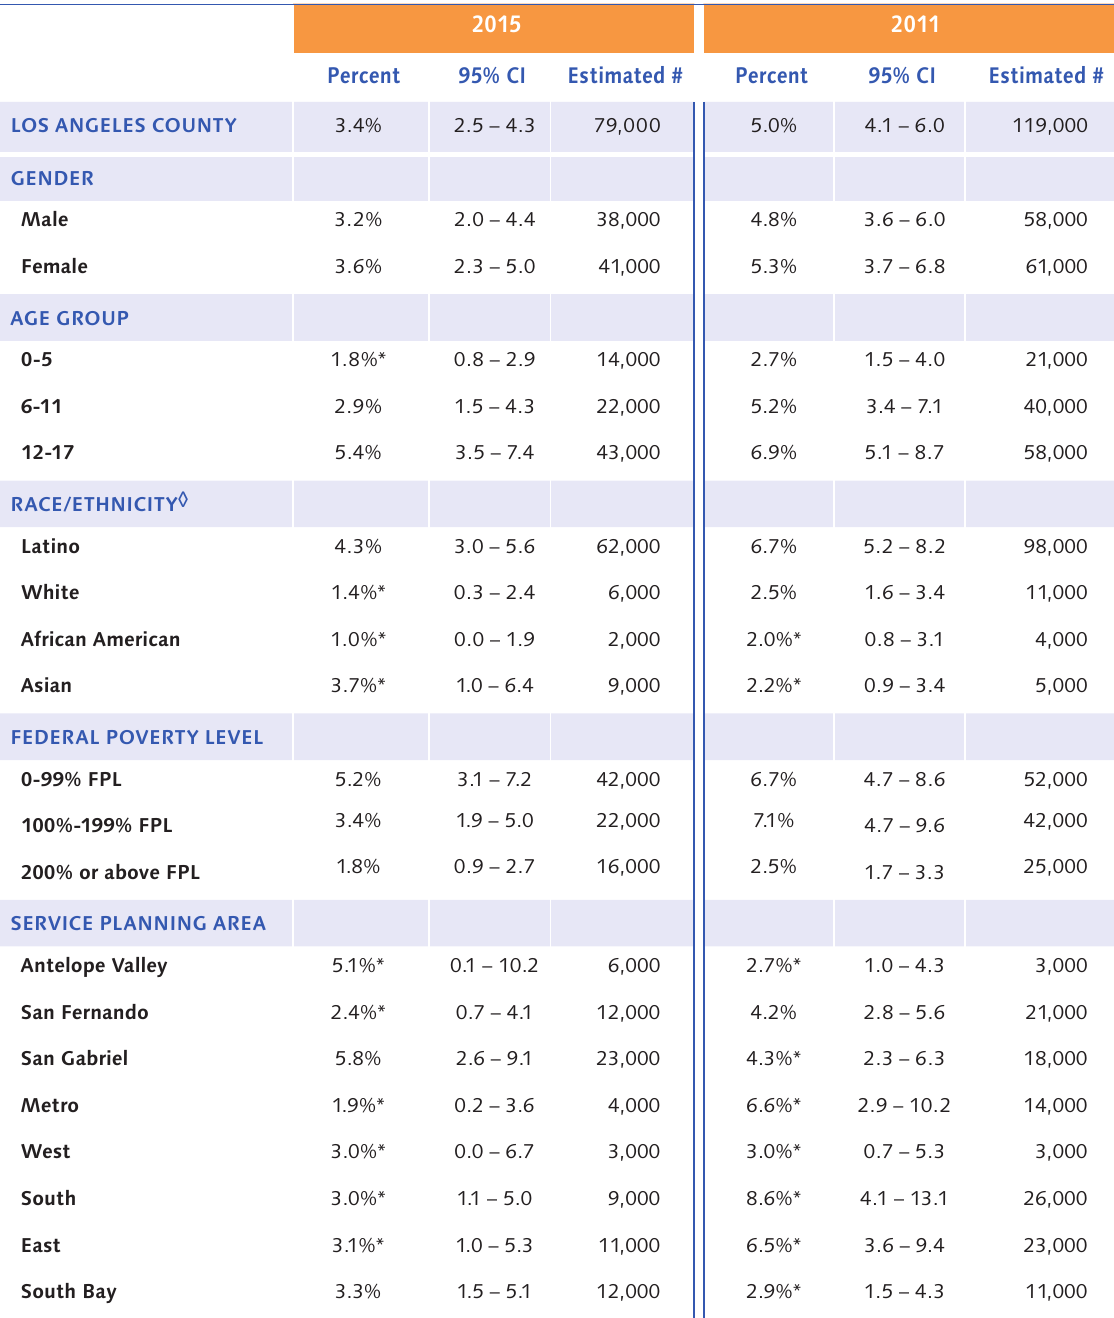
TABLE 2: Percent of Uninsured Children (0-17 years), LACHS 2011 &